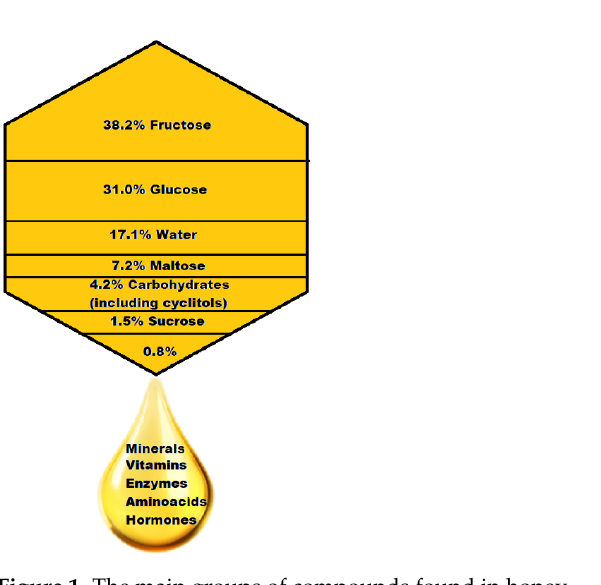
Figure 1. The main groups of compounds found in honey.